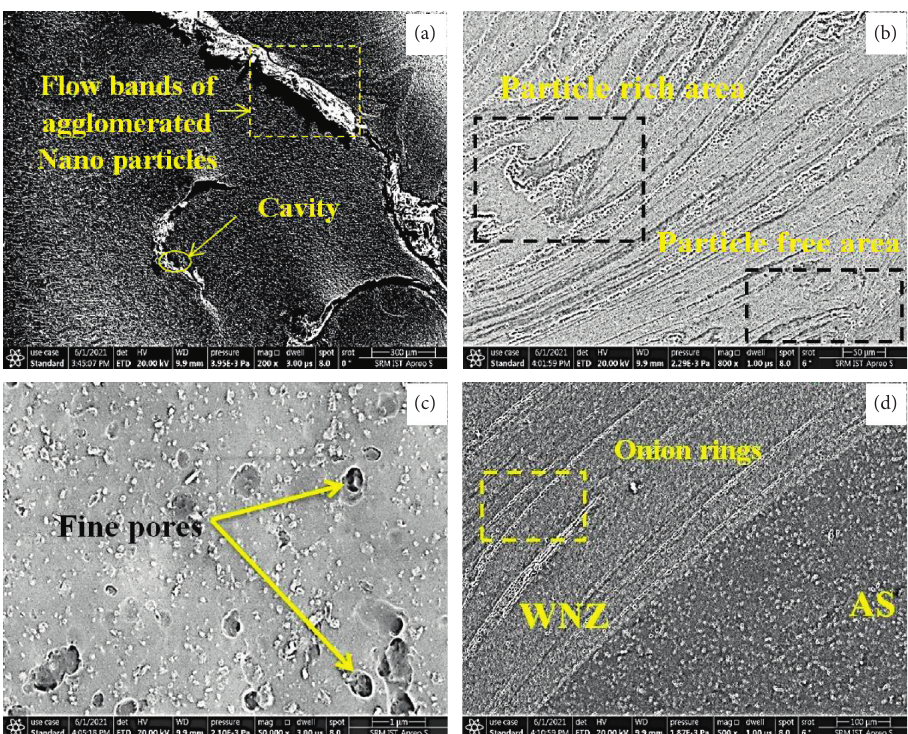
Figure 11: FESEM graphs of (a) interface zone-RS, (b) FSW bottom zone, (c) nugget center, and (d) interface zone-AS.